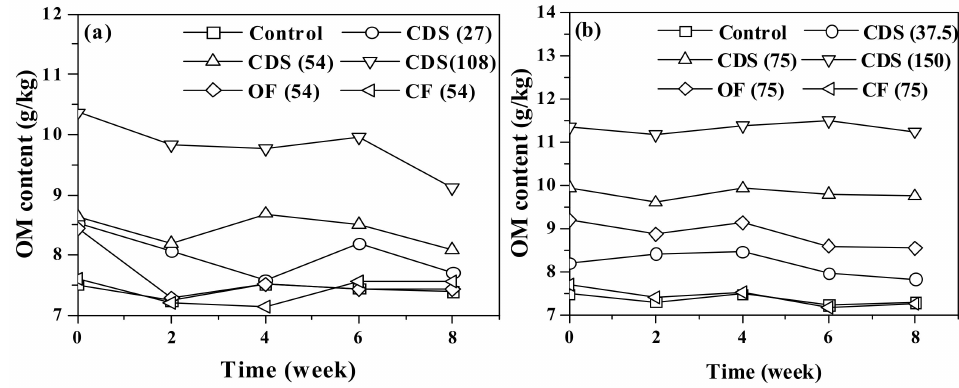
Figure 1. OM in soil affected by application of co-digestion sludge (( a ): phase one, ( b ): phase two).